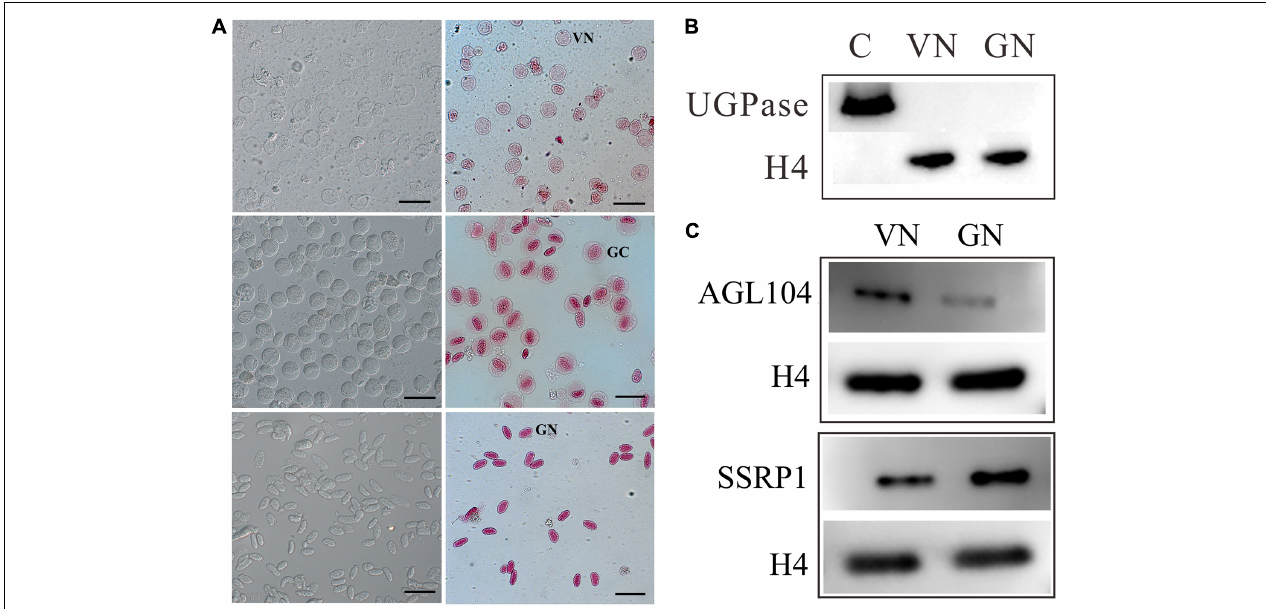
FIGURE 1 | Preparation of nuclear proteins from purified vegetative cell nucleus, VN, and generative cell nucleus, GN. (A) Cytological characterization of purified VC nuclei (VN) and GC nuclei (GN) isolated from lily ( Lilium davidii ) pollens. The images of isolated VNs, GCs, and GNs with aceto-carmine staining were acquired and displayed from the top to bottom row. Scale bars = 100 µ m. (B) Western blot examination of nuclear protein purity. Proteins extracting from VN and GN were separated by 12% SDS-PAGE, transferred to PVDF membranes, and detected with antibodies for UGPase, a cytoplasmic marker, and H4, a nucleus marker. (C) Western blot analysis of the expression patterns of AGL104 (Unigene5688) and SSRP1 (CL774.Contig1) in VN and